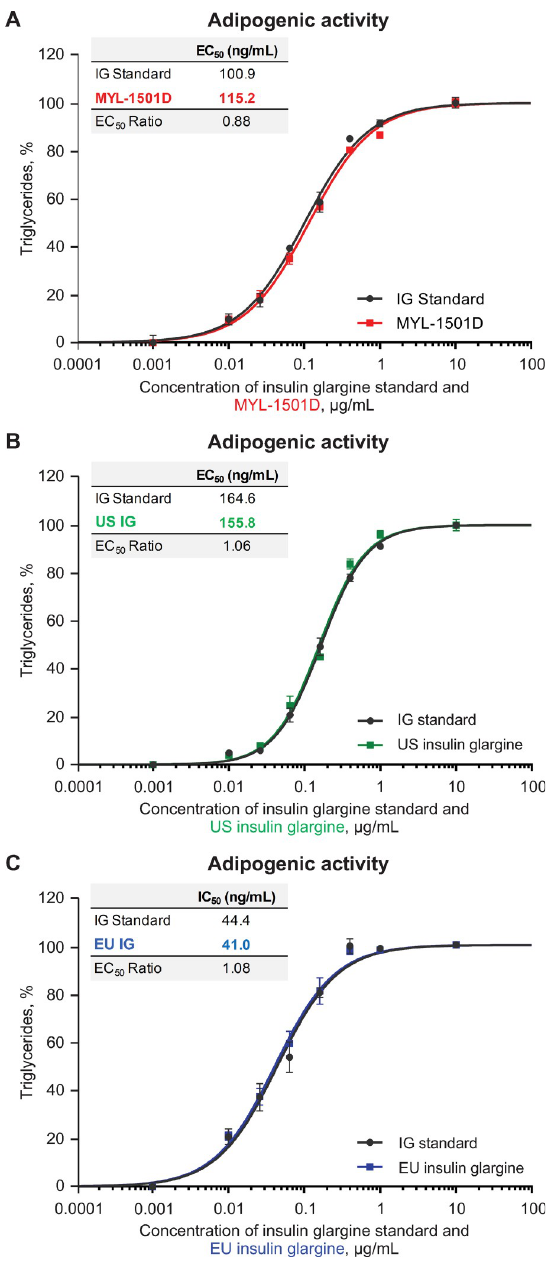
Fig 14. Representative dose-response curves of adipogenesis assay in 3T3-L1 cells. (A) MYL-1501D, (B) US-Licensed Insulin Glargine, and (C) EU-Licensed Insulin Glargine. All samples were analyzed against a common insulin glargine reference standard (IG standard) to normalize against day-to-day variability. Each lot was analyzed using 3 independent dilution preparations on an assay plate. Mean ± SEM for the % triglycerides measured is plotted (y-axis) against the concentration (x-axis). Four parameter logistic curve fit was applied to evaluate EC 50 . Each sample was analyzed on 3 independent assay plates, and average is reported. EC 50 , half maximal effective concentration.